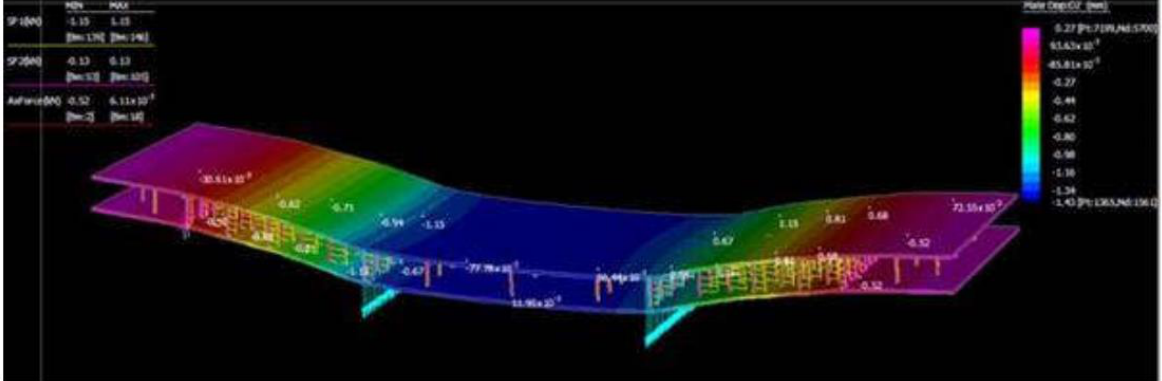
Fig. 22 FEM model of final panel in 4p bending test, model and test results corresponding